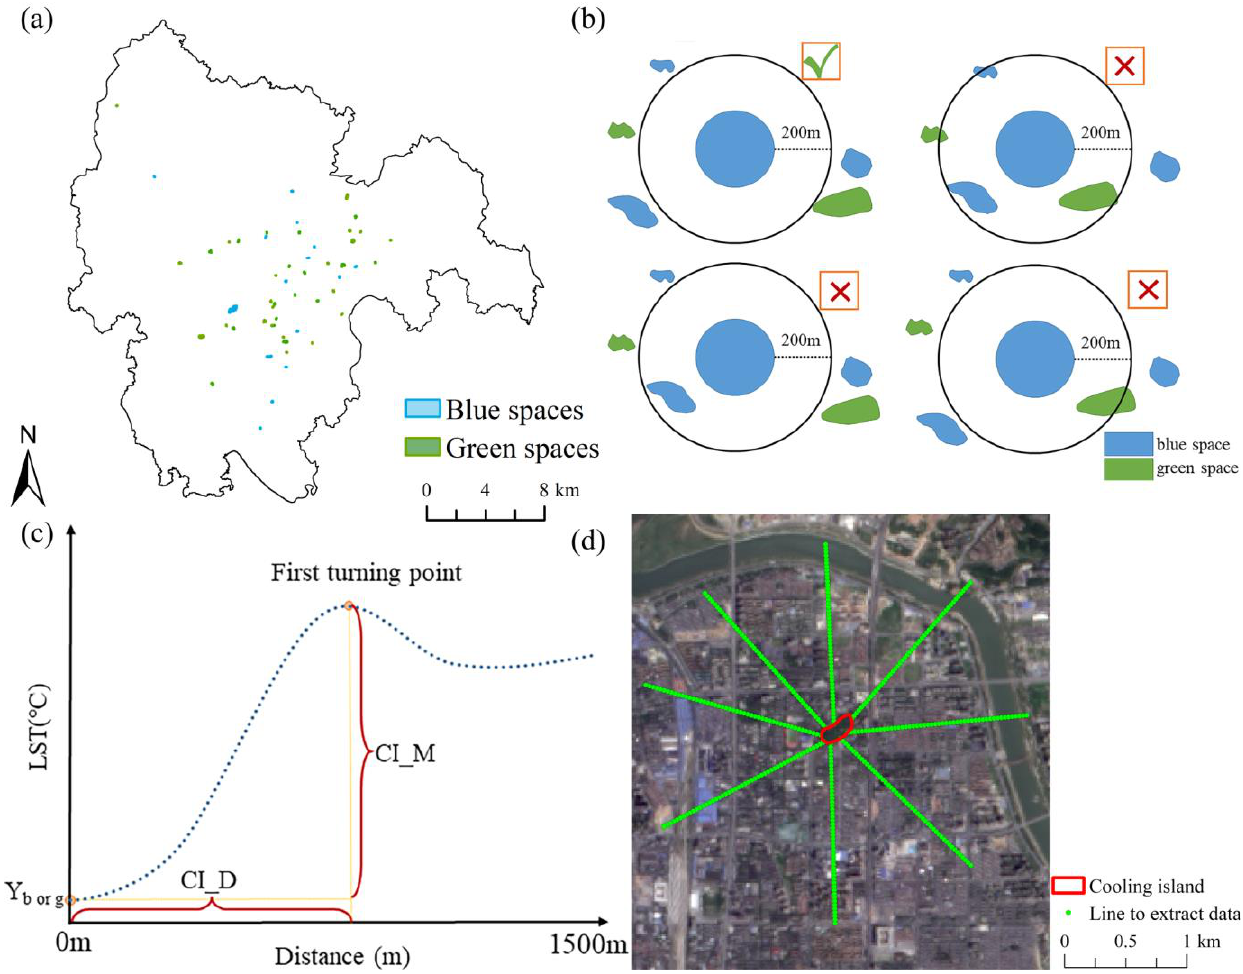
Figure 2. The cooling island effect of blue – green spaces: ( a ) distribution of green – blue spaces; ( b ) selection of blue – green spaces; ( c ) schematic diagram of the cooling island effect of blue – green space, where Y is the mean LST in a single blue or green space, CI_D is the cooling distance (m), and CI_M is the cooling magnitude (°C); and ( d ) eight sampling directions.